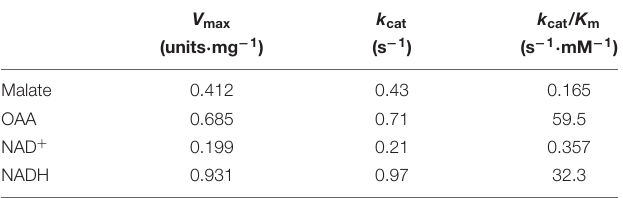
TABLE 1 | Kinetic parameters of Sy MDH.